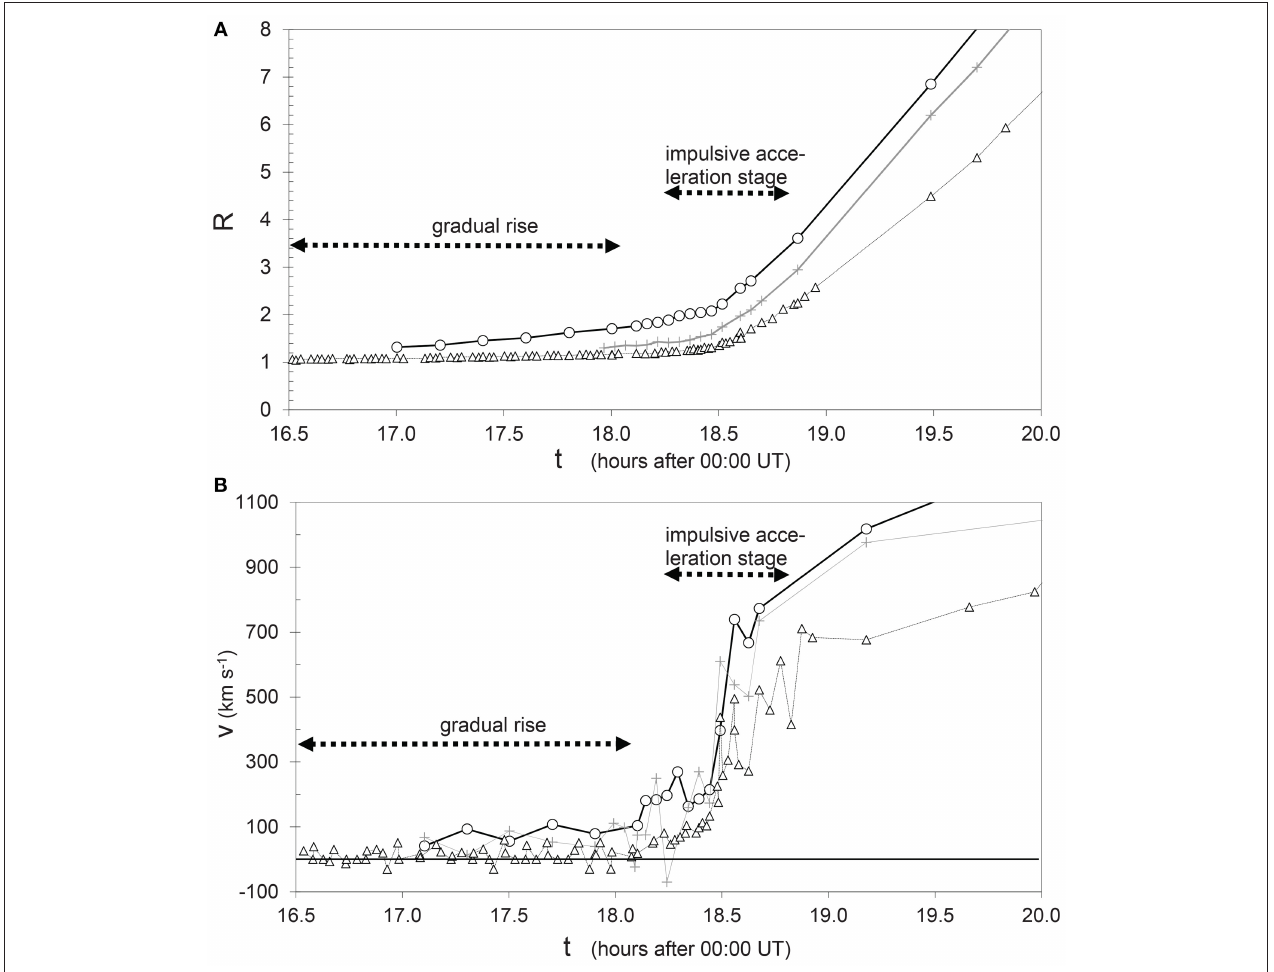
FIGURE 1 | Kinematics of the eruption of May 15, 2001: (A) height–time; (B) velocity–time. The heliocentric distance R is expressed in units of solar radius. Measurements of the frontal rim, top of the cavity, and top of the embedded prominence are shown by circles, crosses, and triangles, respectively. The gradual-rise phase and the impulsive acceleration stage are indicated by horizontal dashed